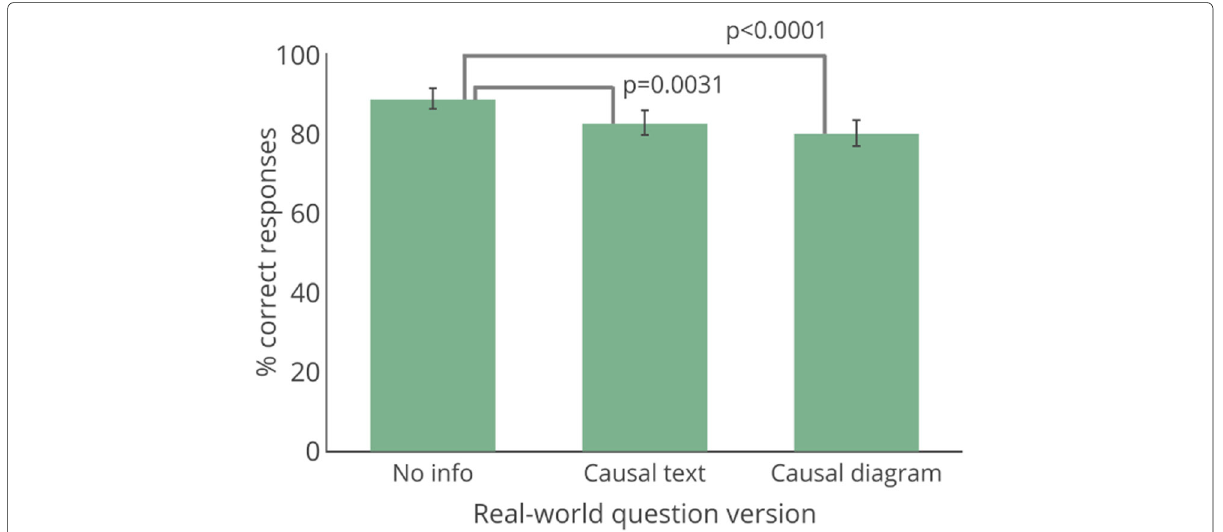
Fig. 2 Results for Experiment 1, with response accuracy by condition. Error bars show 95% confidence interval